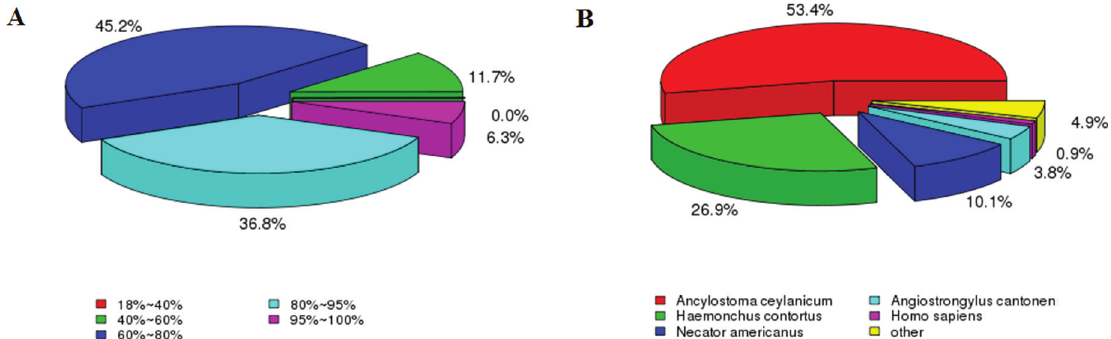
Figure 1 - Summary of the results of sequence-homology searches against the Nr database. (A) Similarity distribution of the closest BLASTX matches for each sequence. (B) A species-based distribution of BLASTX matches for